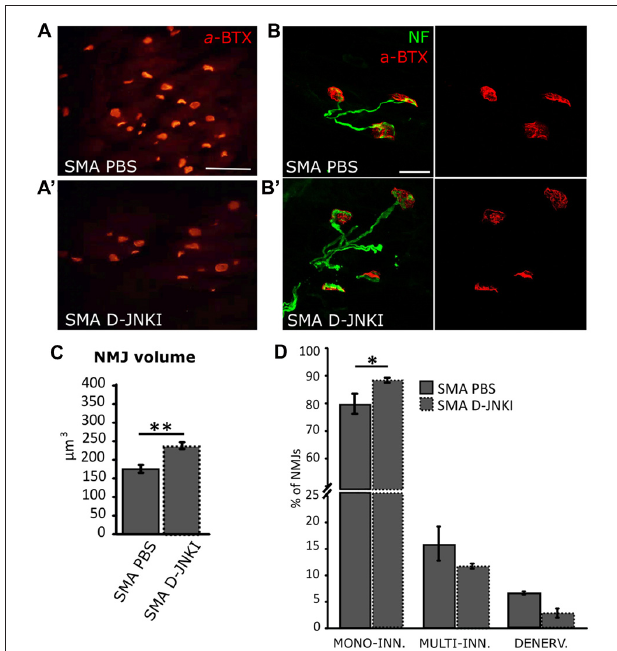
FIGURE 6 | Comparison of NMJ dimensions and innervation between PBS-treated and D-JNKI1 treated SMA mice (A–B’) Images showing NMJ (BTX in red; Nf in green) dimensions in PBS (A,B) and D-JNKI1-treated (A’,B’) SMA quadriceps. (C) Analysis of NMJ volume in PBS treated and D-JNKI1 treated SMA groups. (D) Quantification of the percentage of mono-innervated, multi-innervated and denervated NMJs in SMA PBS and SMA D-JNKI1 groups. Scale bars: 60 µ m (A) ; 20 µ m (B) . ∗ P < 0.05; ∗∗ P <